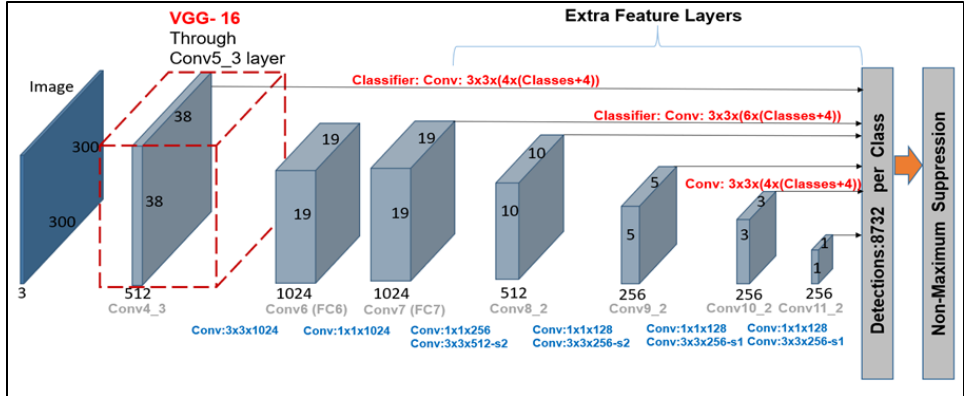
Figure 3. SSD architecture.